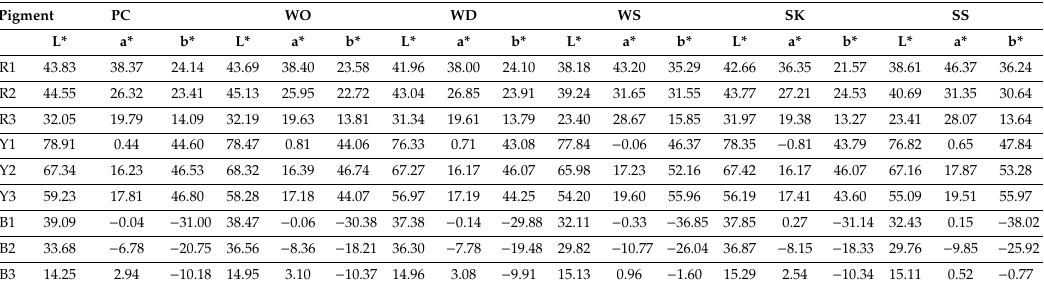
Table 6. CIELAB coordinates for the paintings obtained for the scale adjustment procedures.